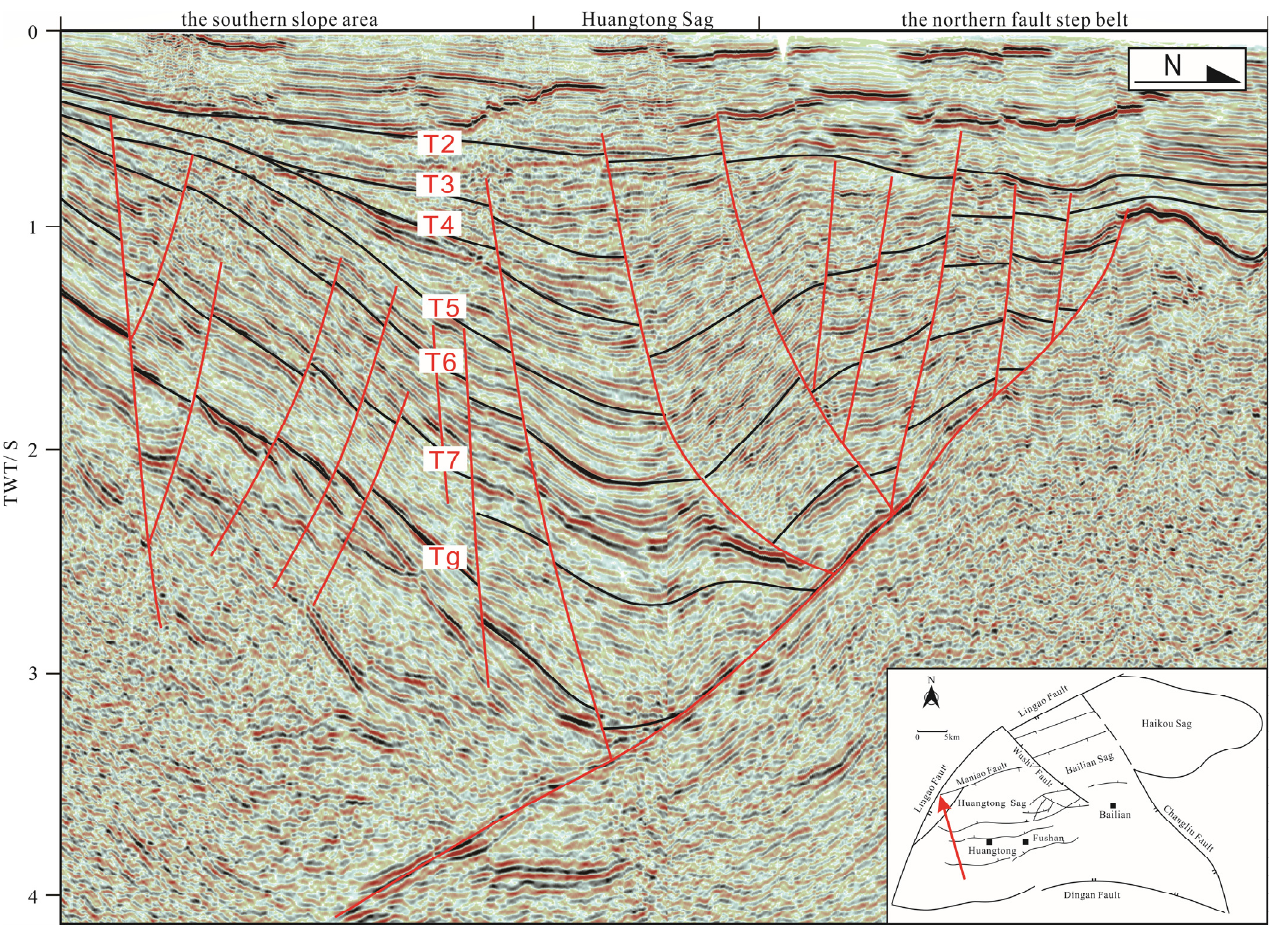
Figure 14. Interpreted seismic section (S-N direction) showing the consequent fault in the Chaoyang area.